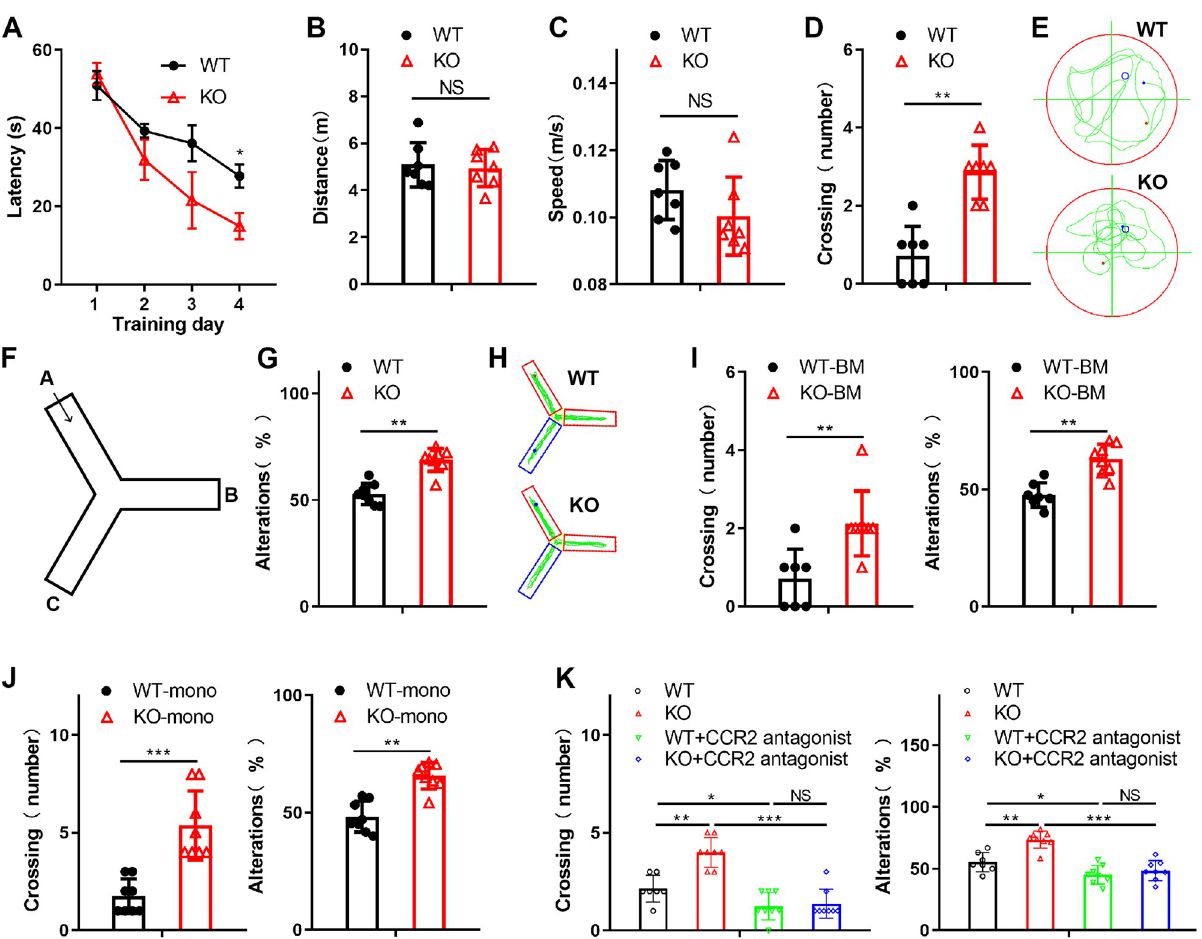
Fig 1. AU : Abbreviationlistshavebeencompiled = updatedforthoseusedinFigs 1 to 7 : Pleaseverifythatallentriesarecorrect : METTL3 deficiency in monocyte-derived macrophage improve the cognition in a mouse model of AD. (A–E) The WT or KO mice were trained and learned to find a hidden platform over 4 consecutive days. The escape latencies of the WT or KO mice in the MWM task on training days were recorded (A). On Day 5, probe trials were performed with the platform absent, and the travel distance (B), swim speed (C), and number of platform area crossings (D) were assessed. (E) Representative MWM swim plots for the WT and KO mice on Day 5. (F) Experimental design of the YMT. (G) The spatial working memory of the WT or KO mice induced by A β in the YMT. Alternations were counted as the percentage of “correct” alternation/total entries. “Correct” alternation means entry into all 3 arms on consecutive choices. (H) Representative YMT plots for the WT and KO mice induced by A β . (I) The learning and memory impairment of the A β -treated WT mice reconstituted with either WT or KO BM was examined by the MWM task and YMT. (J) The spatial learning and memory of mice with WT or KO monocyte transplantation were examined by the MWM task and YMT. (K) The learning and memory impairment of the A β -treated WT or KO mice injected with the CCR2 antagonist PF-4136309 (2 mg/kg) was assessed by the MWM task and YMT. All data in the figure are shown as the mean ± SD except for (A). P < 0.05 ( � ), P < 0.01 ( �� ), P < 0.001 ( ��� ), NS means no significant difference. Underlying data can be found in S1 Data. A β , amyloid beta; AD, Alzheimer’s disease; BM, bone marrow; KO, knockout; MWM, Morris water maze; WT, wild type; YMT, Y maze test.